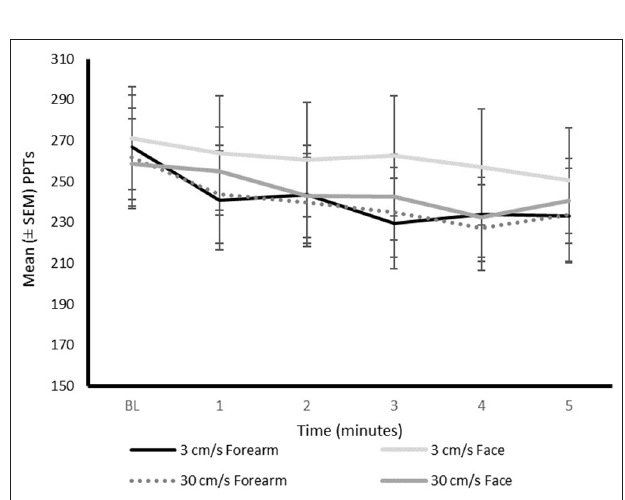
FIGURE 3 | Mean PPTs (kPa) during continuous stroking on the differing regions at the differing time intervals. BL, baseline; NRS, numerical rating scale; PPTs, pressure pain